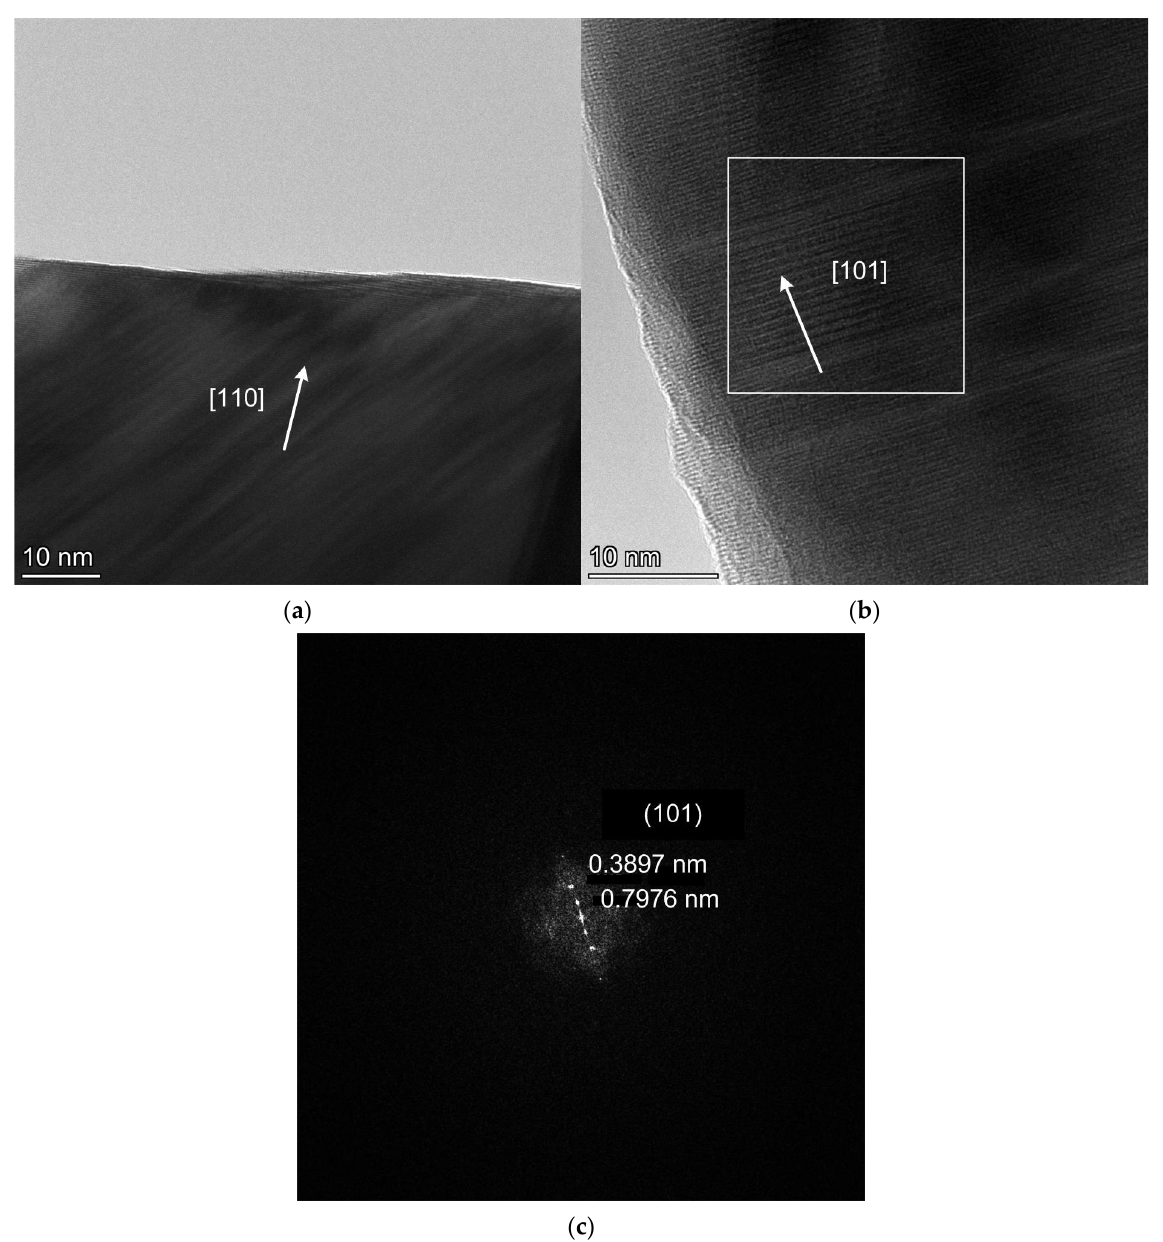
Figure 7. HRTEM images of LCNO_01 sample showing ordered planar defects—( a , b ); FFT image of LCNO_01 sample from ( b ) (area marked by white square) showing orientation of planar defects—( c ).